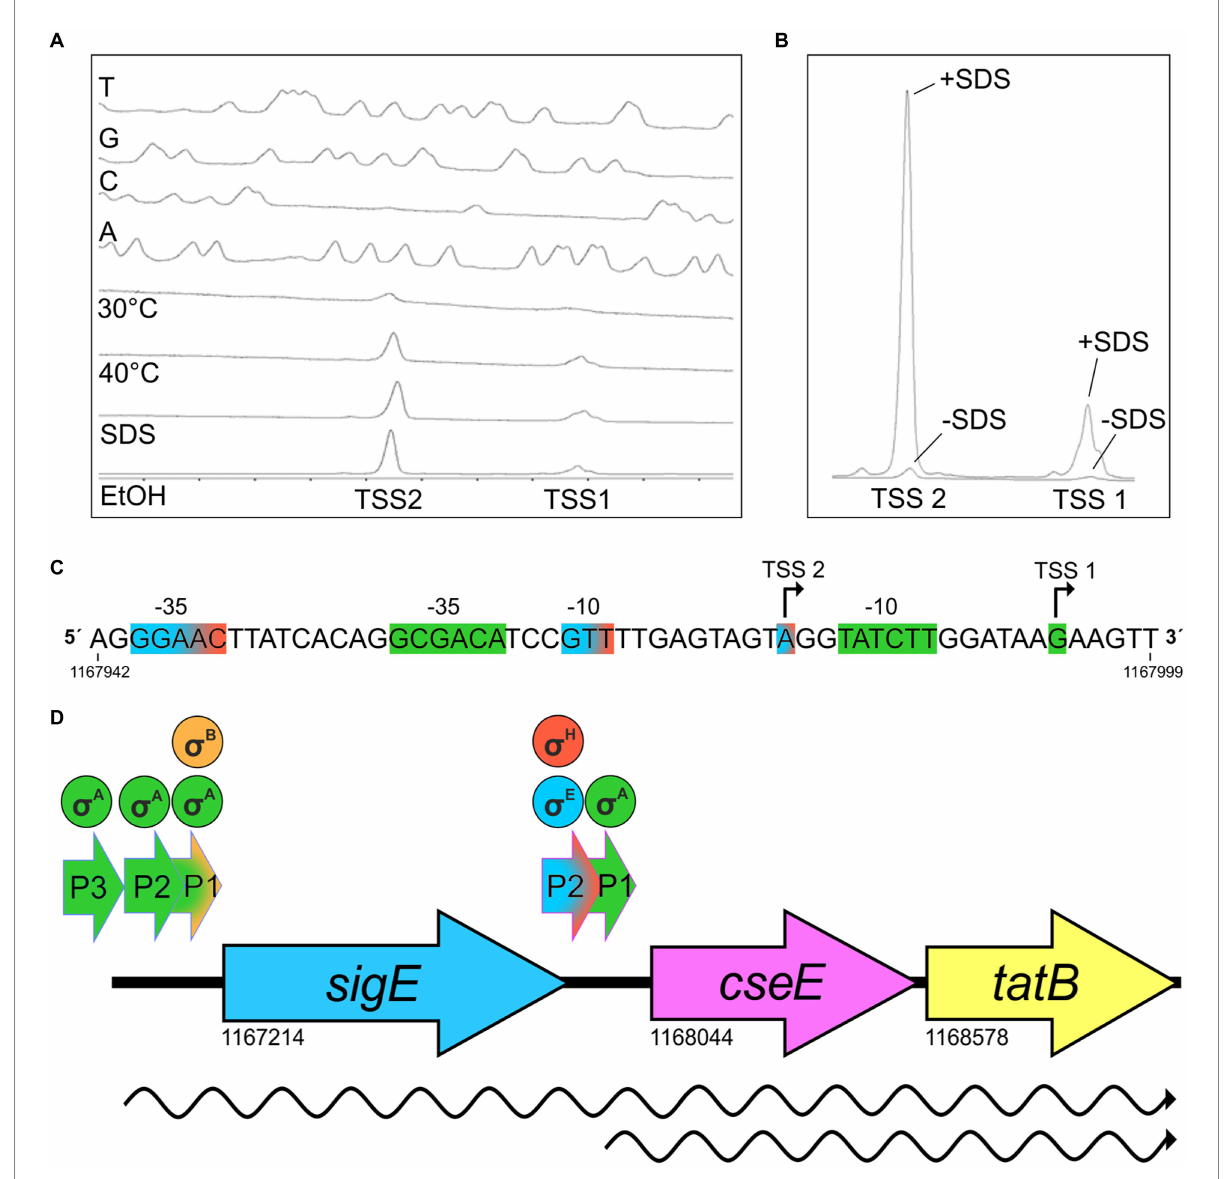
FIGURE 2 Determination of transcriptional start sites (TSS) of cseE gene by primer extension analysis (PEX), sequence of corresponding promoter region, and structure of the whole sigE - cseE - tatB operon. (A) Determination of cseE transcription start sites by PEX. The bottom peaks represent cDNA synthesized in reverse transcription using RNA from C. glutamicum (pET2P cseE ) cultivated at 30 ° C or with stresses (40 ° C for 60 min; 0.01% (w/v) SDS; 4% (v/v) ethanol). The peaks (T, G, C, A) represent the products of sequencing reactions carried out with the same fluorescently labeled primer as that used for reverse transcription. The fluorograms are reversed and labeled complementarily to the respective sequences of the coding strand shown (C) . (B) The same PEX reaction signals as in 2A (without/with SDS; -SDS/+SDS) shown in absolute size. To compare the strength of the signals, the absolute size of peaks marked -SDS and + SDS are shown. (C) Nucleotide sequence of cseE upstream region. Transcription start sites (TSS) detected by PEX are indicated by bent arrows. The proposed promoter motifs corresponding to the σ Α -controlled TSS1 are highlighted in green, the σ H / σ Ε -controlled TSS2 in blue/red. Genomic coordinates of the 5 ′ and 3’ends of the promoter sequence taken from GenBank RefSeq BX927147 are shown. (D) Scheme of sigE - cseE - tatB operon of C. glutamicum and location of promoters and transcripts. The promoters are indicated by short arrows above the operon structure. Transcripts are shown as wavy lines. Sigma factors which are active in transcription from individual promoters are shown in circles above the promoters. The scheme and the genomic coordinates of the initiation codons are based on the C. glutamicum ATCC 13032 genome sequence (GenBank RefSeq BX927147) and results of primer extension